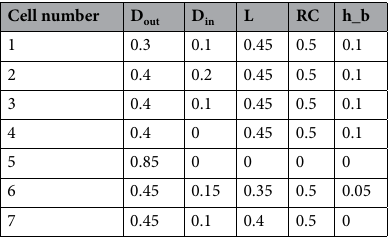
Table 1. Parameters of the cells used to form the beam steering structure; all dimensions are in µm.